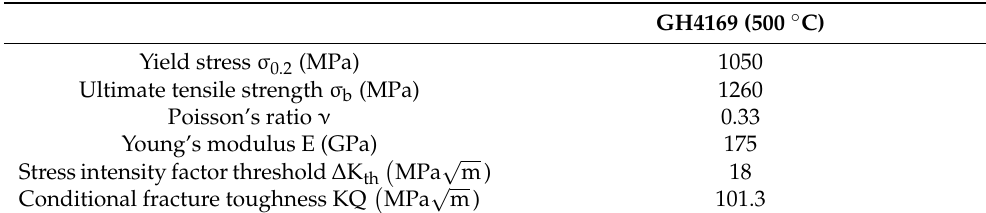
Table 1. Mechanical properties of the GH4169 alloy at 500 °C.